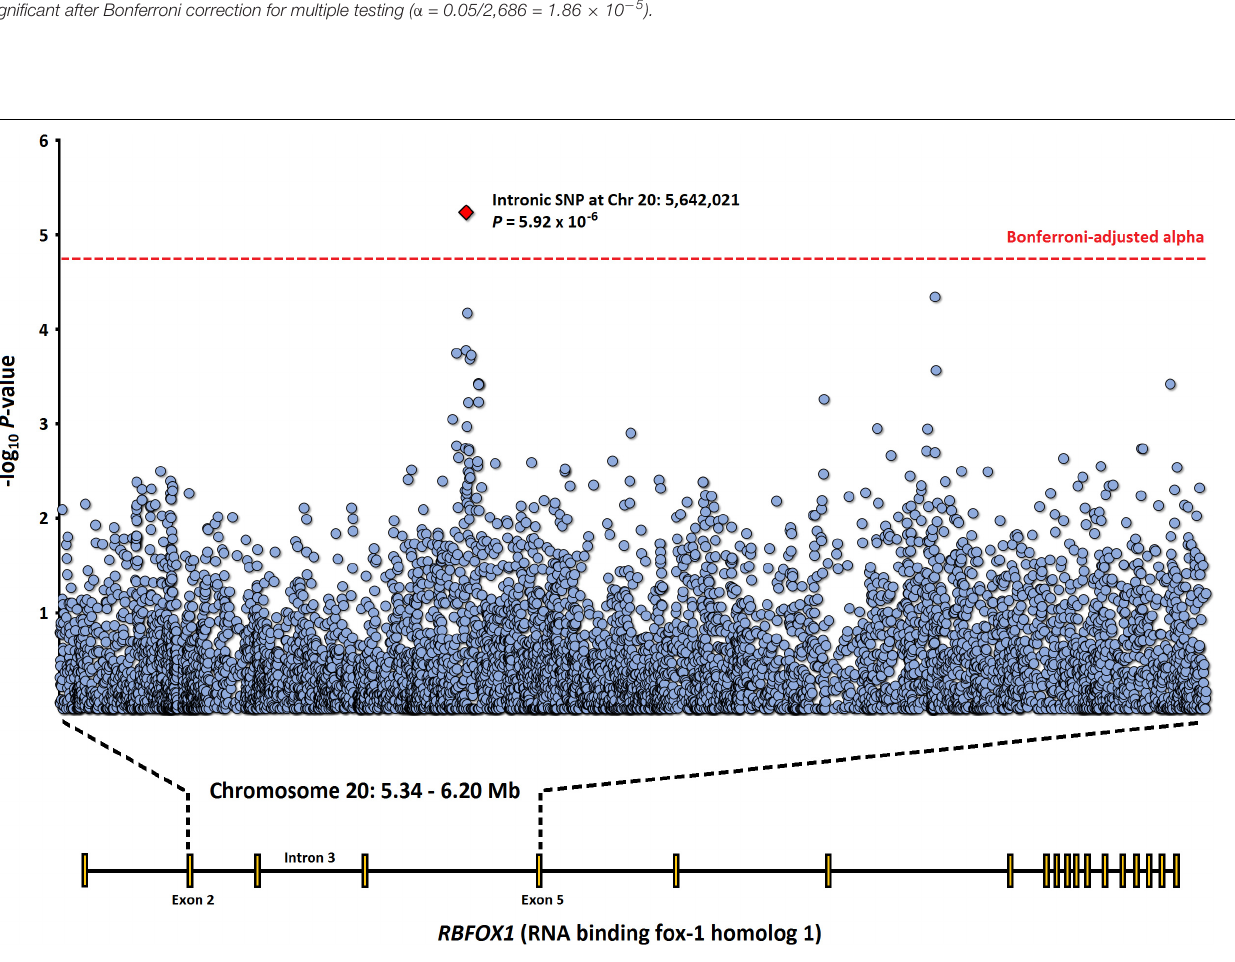
The table lists the top ten gene homologs for human candidate genes for GGE and related epilepsies based on their top SNP association results for epileptic seizure in baboons.